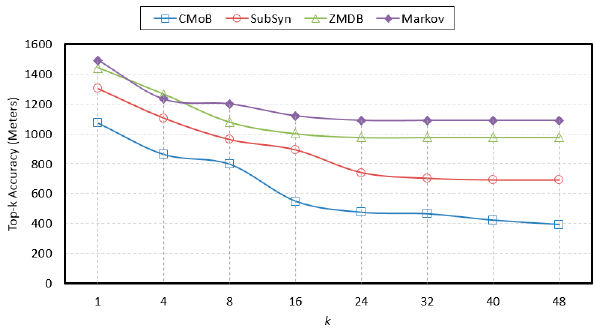
Figure 14. Top- k Error with different k .